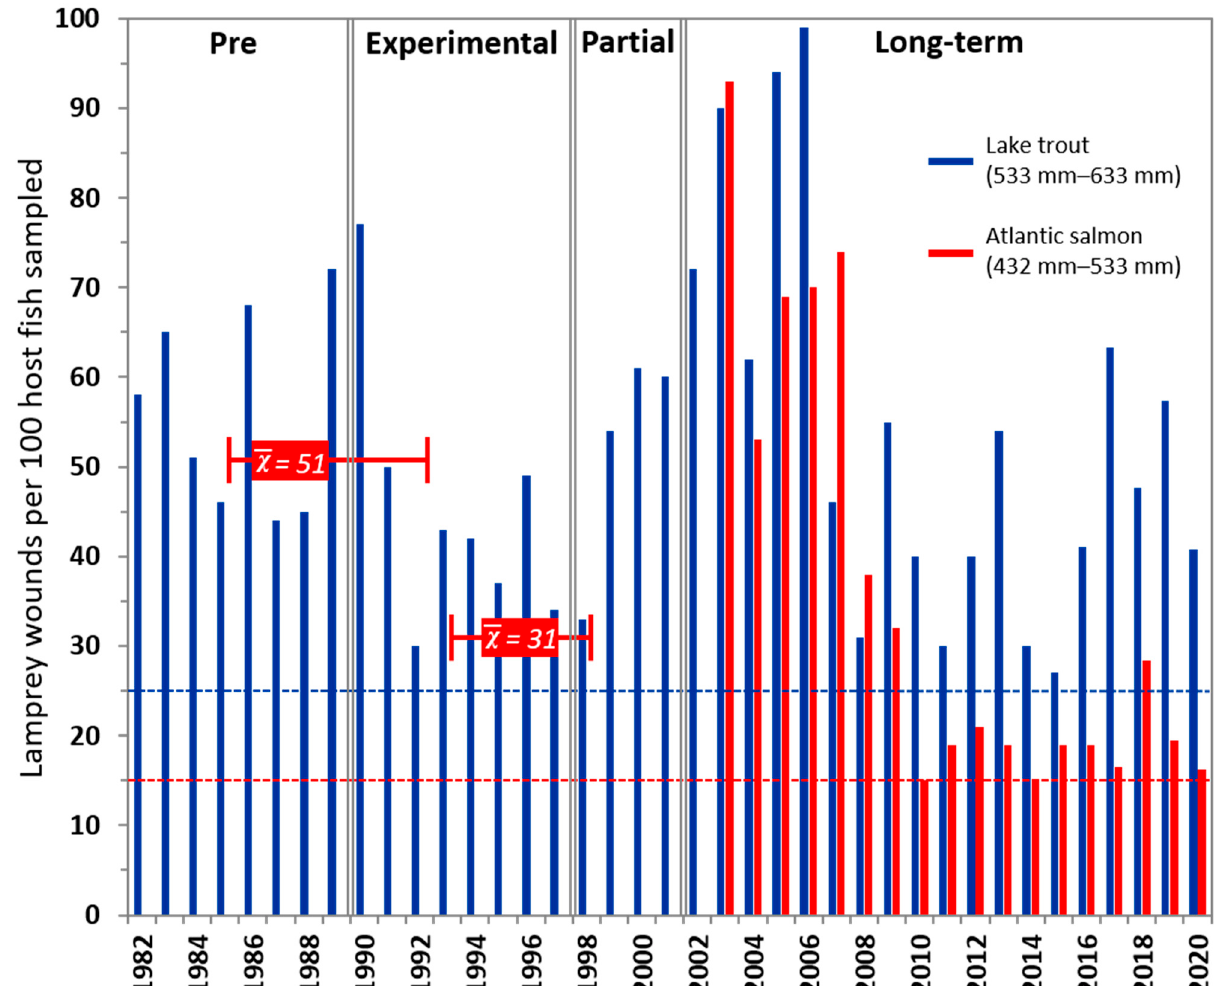
Figure 2. Sea lamprey wounding rates on lake trout and Atlantic salmon measured as number of wounds per 100 fish [18]. The vertical double lines separate the periods before lamprey control (Pre), the 8 year experimental control program (Experimental), the period of partial control (Partial), and the long-term control program (Long-term). Non-standardized collection effort among years for Atlantic salmon wounding data, prior to the Long-term program, led to grouping and averaging available data across the years 1985–1992 and 1993–1998 to approximate and reflect the time-lag responses to lamprey parasitism during the Pre and Experimental control periods, respectively. Horizontal dashed lines indicate the management goals for lake trout (25) and Atlantic salmon (15).